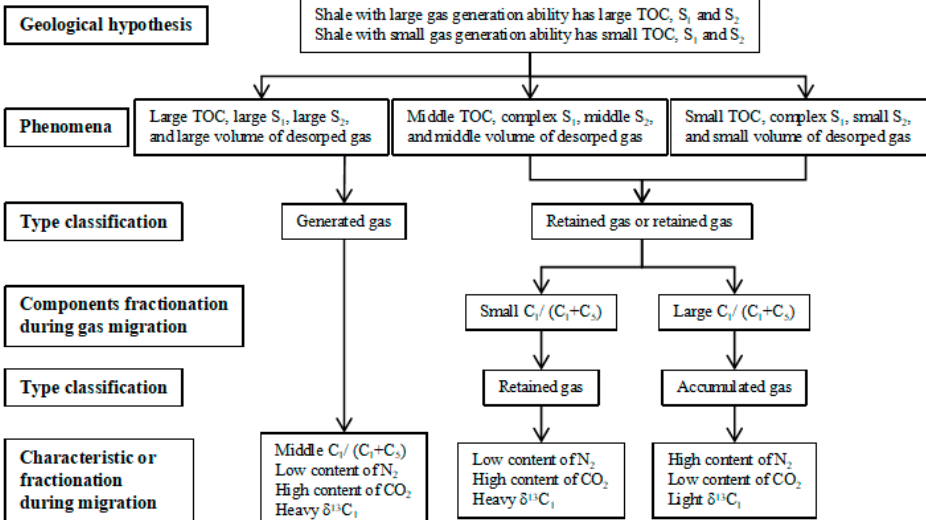
Figure 7. Histogram showing the cores, geological parameters and gas-type classifications.